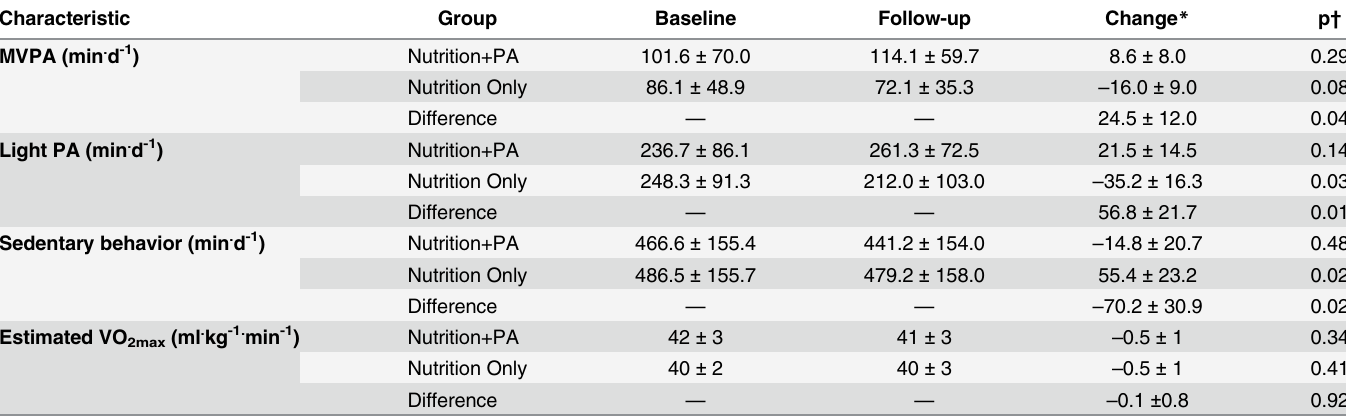
Table 3. Accelerometry and fitness data. Unadjusted mean ± SD at baseline and follow-up by group assignment; mean change within group and differ- ence between groups ± SE, adjusted for wear time and design parameters. Characteristic